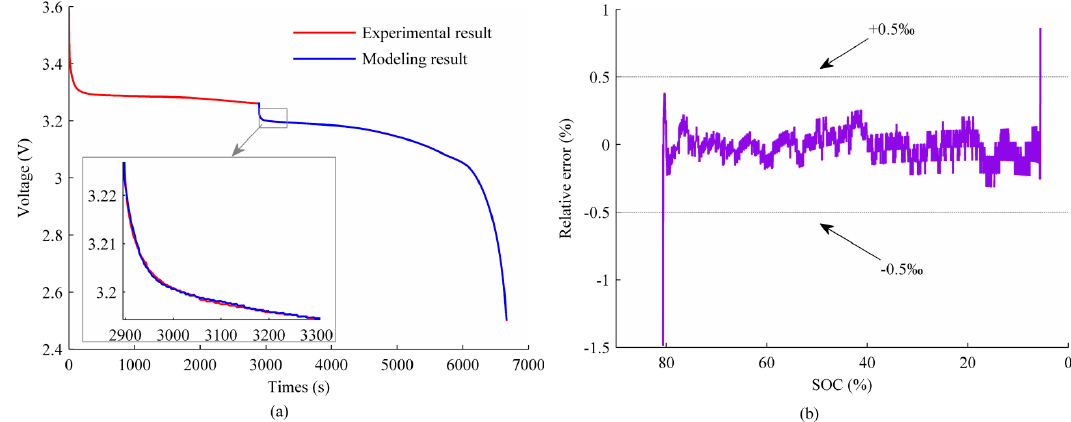
Figure 7. Modeling result under { i 1 = − 1.3 A, i 2 = − 3.9 A, SOC j = 79%}: ( a ) Terminal voltage curve estimation; ( b ) Relative error.